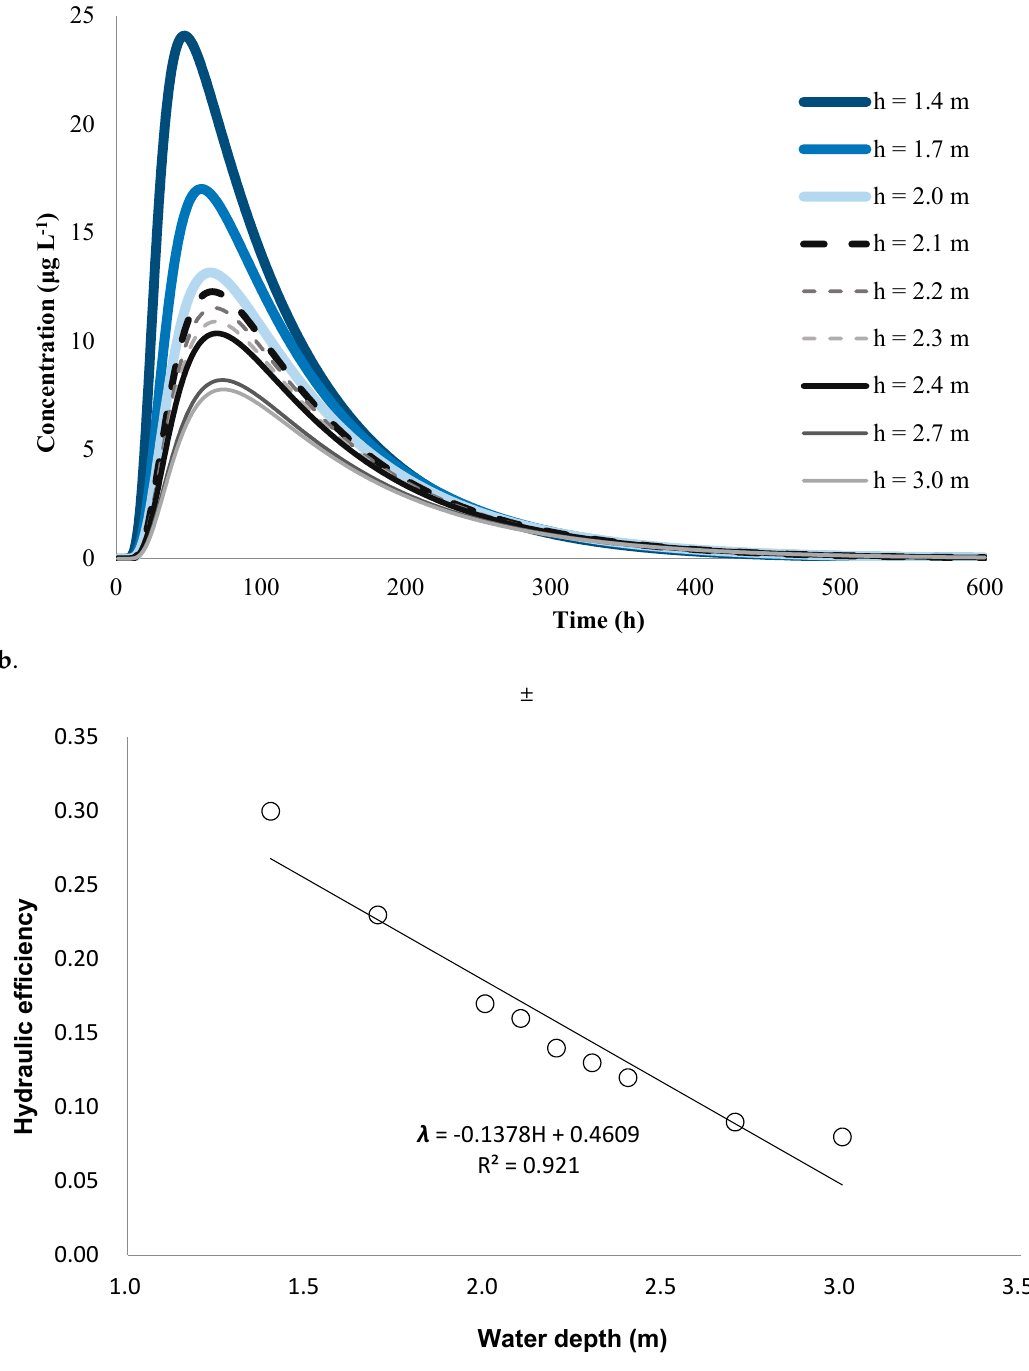
Figure 5. ( a ) Tracer concentration hydrograph and ( b ) hydraulic efficiency at the pond outlet across the entire pond for different water depths.